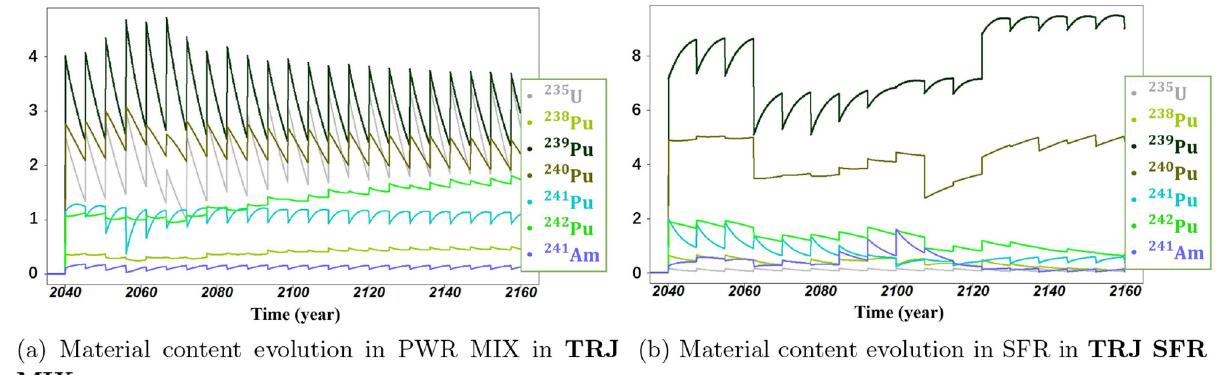
Fig. 5. Content evolution of plutonium isotopes, 235 U and 241 Am in PWR MIX and in SFR (in % of the heavy nuclides present in the considered